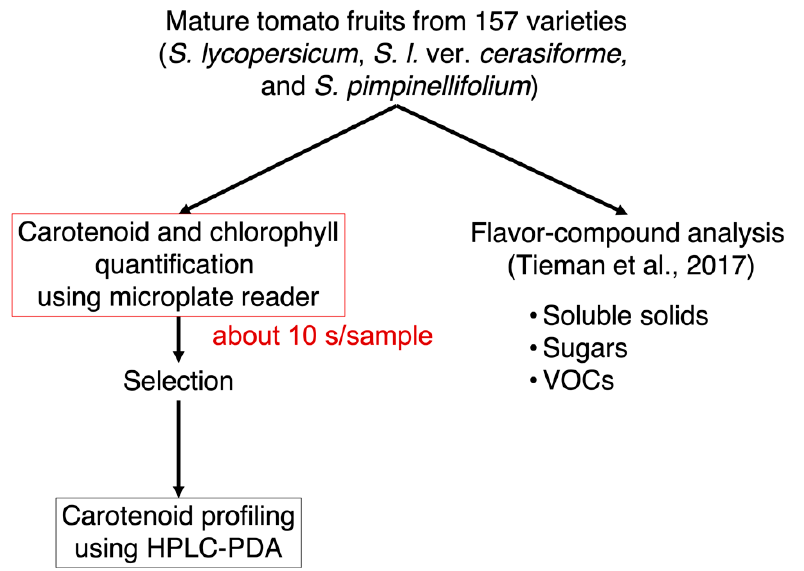
Figure 1. Workflow to quantify nonpolar pigments and flavor-related compounds in tomato fruits. The pigments (carotenoids, lycopene, and chlorophylls a and b) were first quantified by using a multimode microplate reader. After comparison of the pigment composition, several lines were chosen to conduct HPLC-PDA analysis for the quantification of three carotenoids, as well as chlorophylls. Data for flavor-related compounds such as soluble solids, sugars, and VOCs were obtained from Tieman et al. [21] .